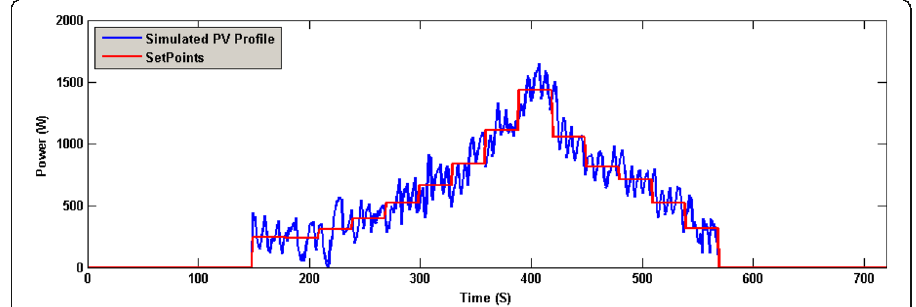
Fig. 10 Real-time results of PV emulator in BUS